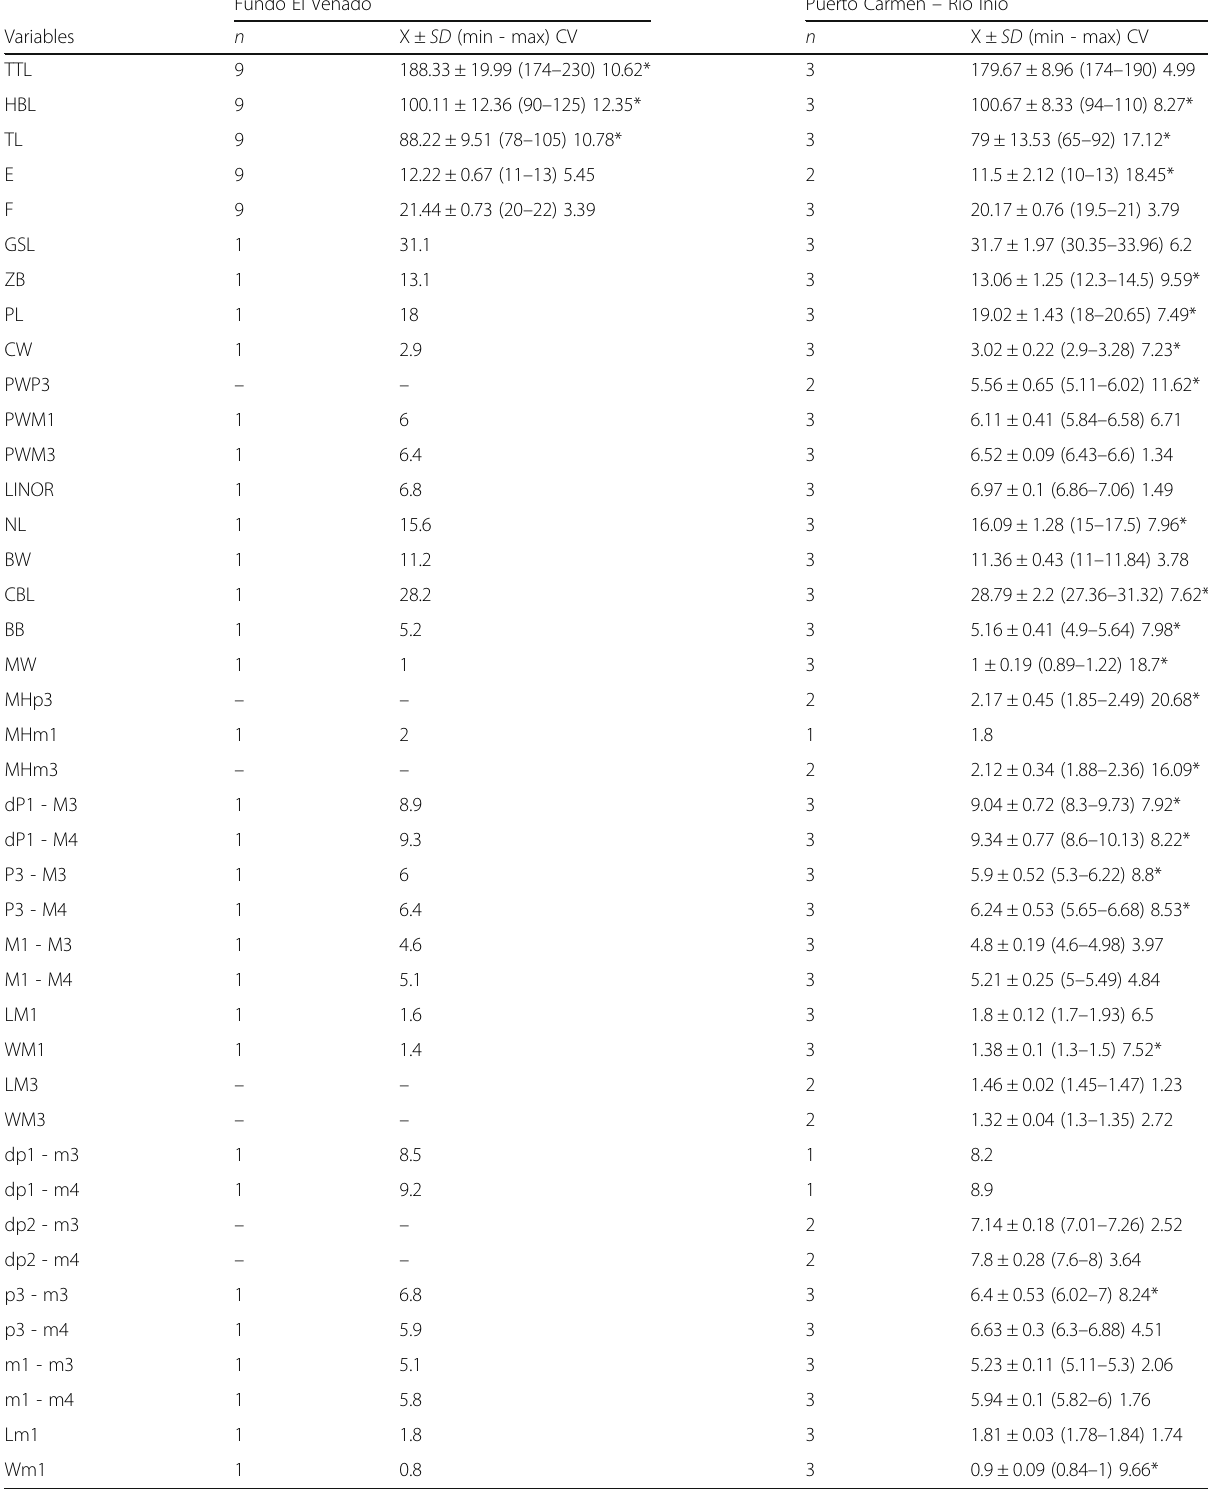
Table 2 External and craniodental measurements of Rhyncholestes raphanurus Osgood for pooled samples from Chiloé Island, Chile. Total number of specimens ( n ), mean (X), SD, minimum and maximum of each variable, and coefficient of variation are presented for each locality. Asterisks indicate Coefficient of Variability (CV) values higher than seven, following Bedeian and Mossholder [34] Fundo El Venado Puerto Carmen – Río